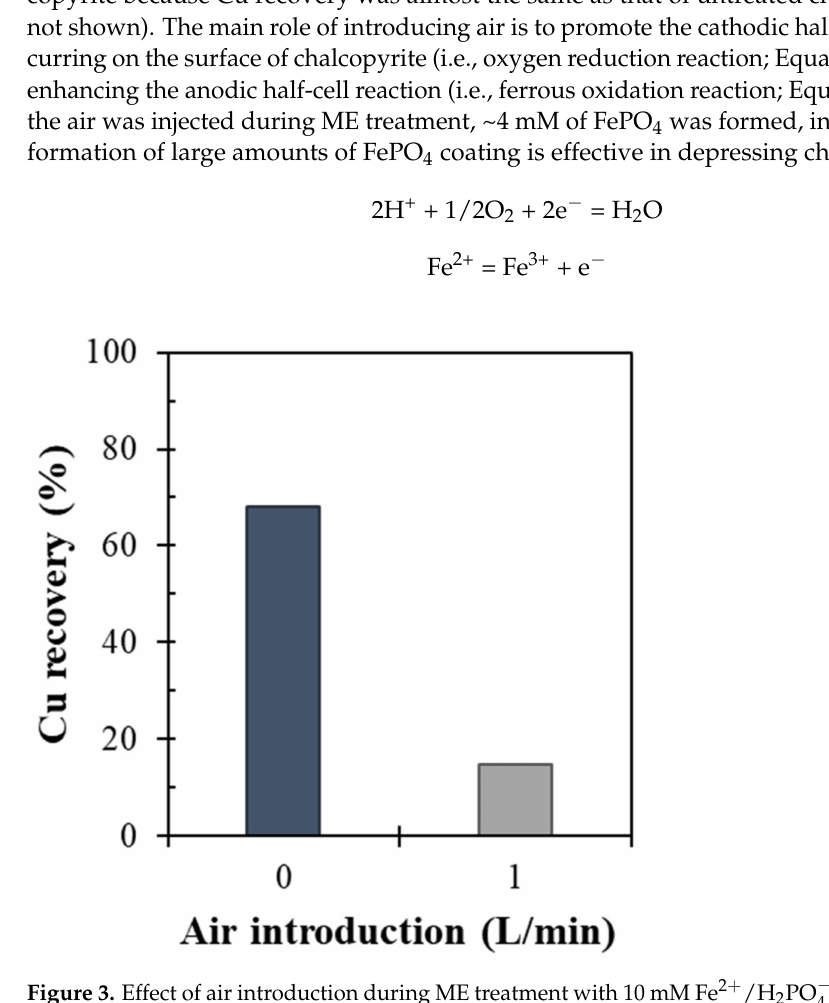
on the floatability 4